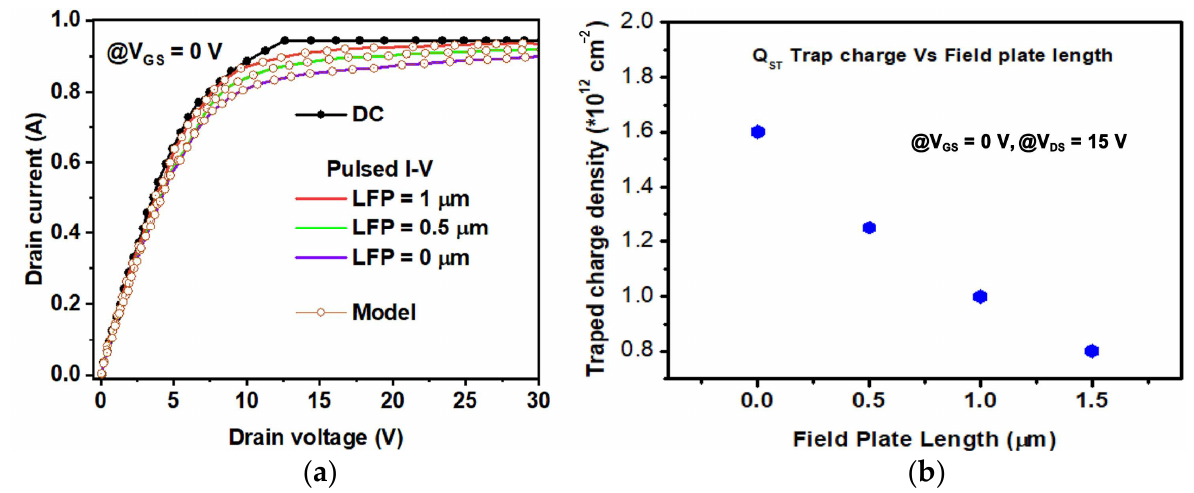
Figure 6. AlGaN/GaN HEMT characteristics with different field plate lengths. ( a ) Pulsed I DS -V DS characteristics with Quiescent Voltage (V GS,Q = −8 V and V DS,Q = 50 V); ( b ) trapped charge (Q ST ). Adapted with permission from Ref. [39]. Copyright 2021 by Elsevier.